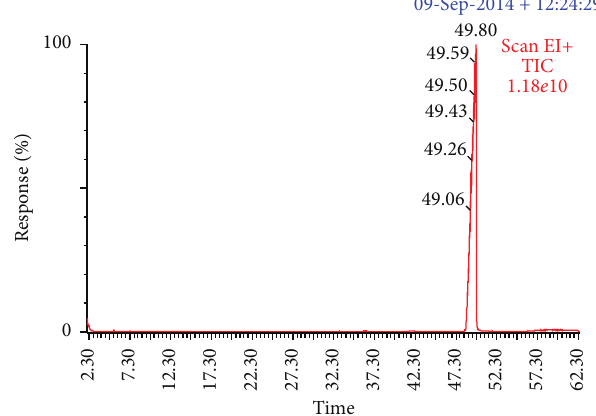
Figure 2: GC-MS chromatogram for squalene extracted from liver oil of Echinorhinus brucus .